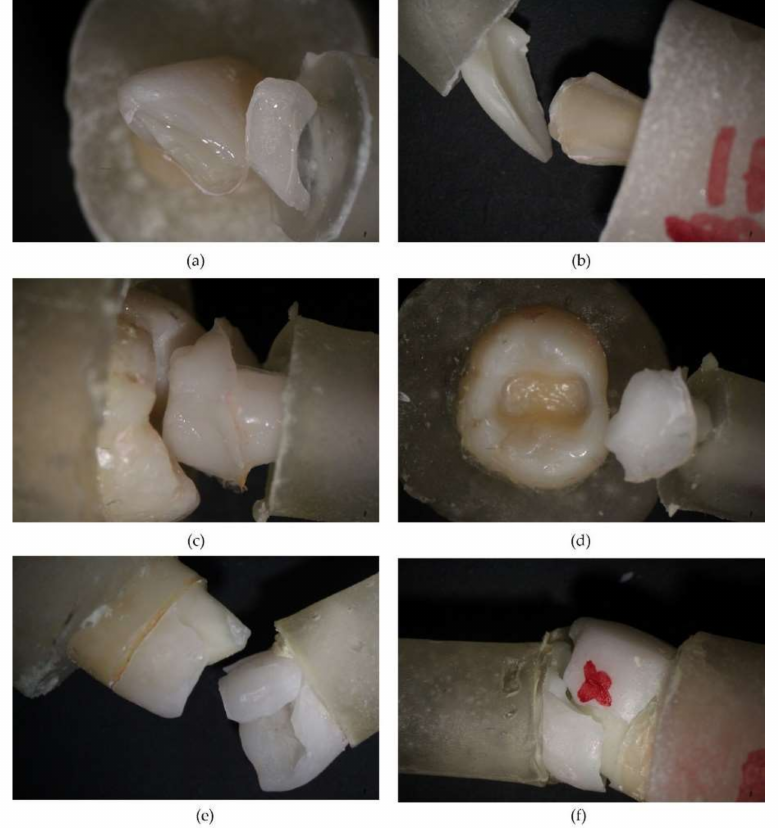
Figure 7. Optical microscope evaluation after mechanical pull-out test: ( a ) veneer fractured specimen; ( b ) fractured ceramic veneer after decementation; ( c ) inlay debonded specimen; ( d ) inlay restoration and preparation after debonding; ( e ) fractured crown restoration; ( f ) aspect of ceramic crown after